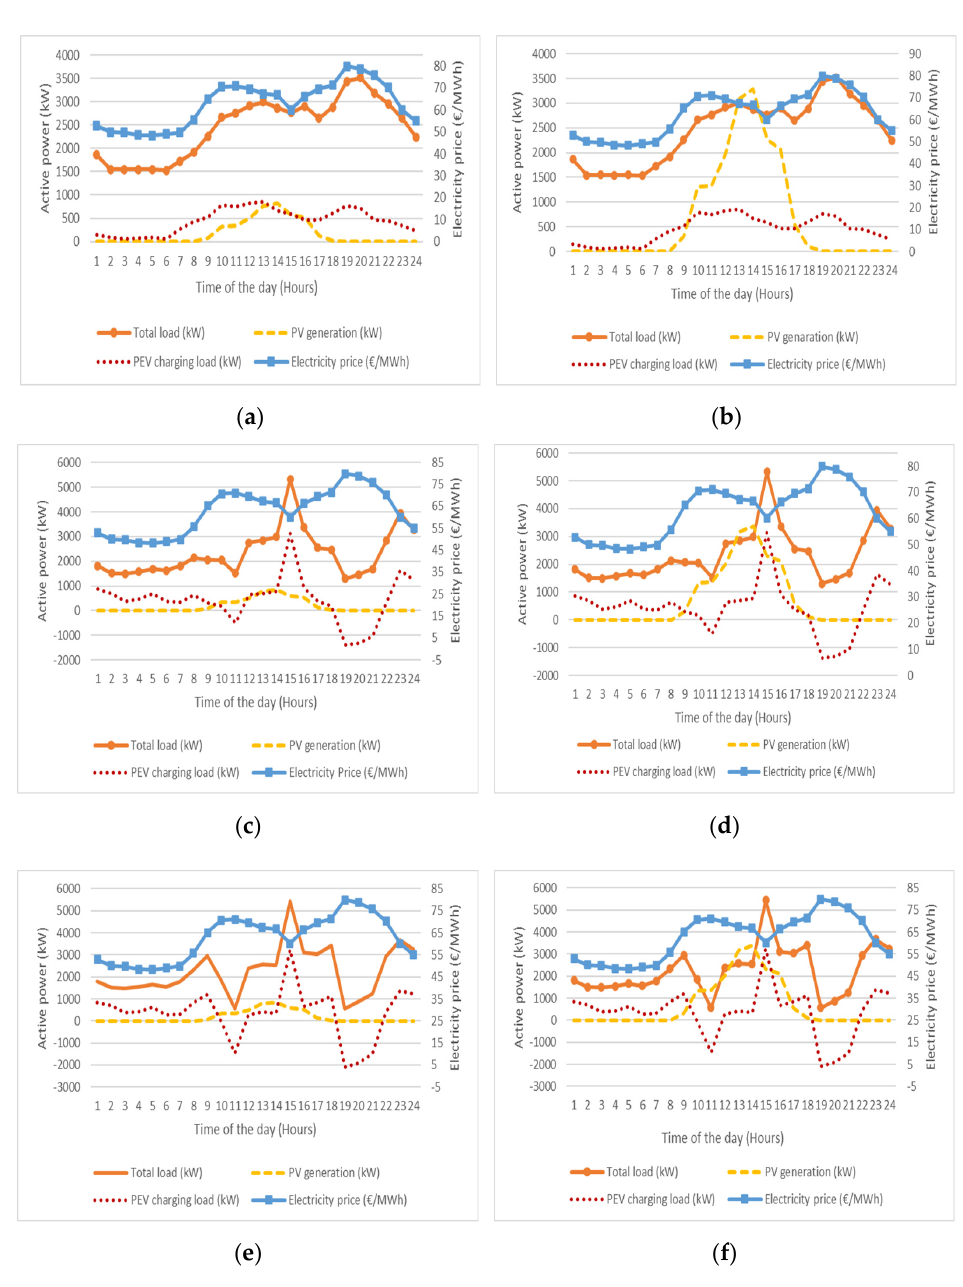
Figure 16. Electricity price, PV generation, PEV charging load and total load of the microgrid when PEV number = 500 and ( a ) PV = 1000 kWp and charging strategy: uncoordinated, ( b ) PV = 4000 kWp and charging strategy: uncoordinated, ( c ) PV = 1000 kWp and charging strategy: proposed s1, ( d ) PV = 4000 kWp and charging strategy: proposed s1, ( e ) PV = 1000 kWp and charging strategy: proposed s2 and, ( f ) PV = 4000 kWp and charging strategy: proposed s2.